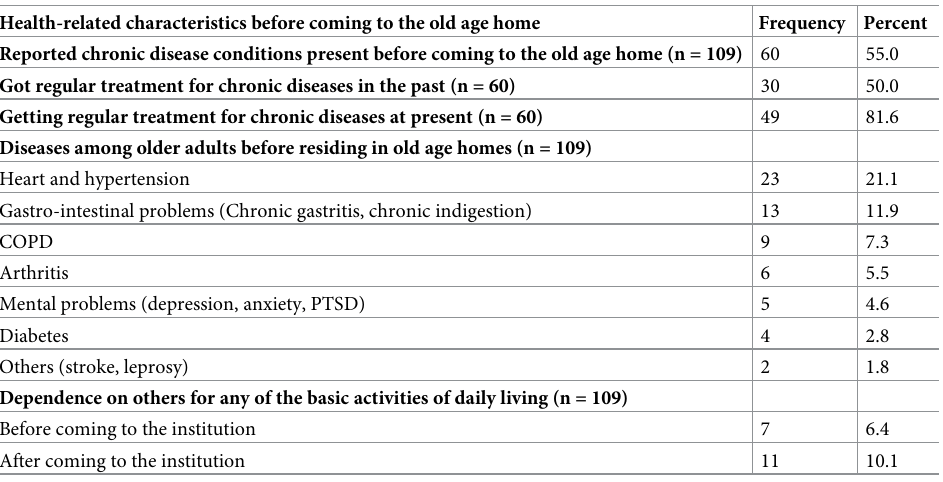
Table 2. Health-related information of older adults transferred to the old age homes (n = 109). Health-related characteristics before coming to the old age home Frequency Percent Reported chronic disease conditions present before coming to the old age home (n = 109) 60